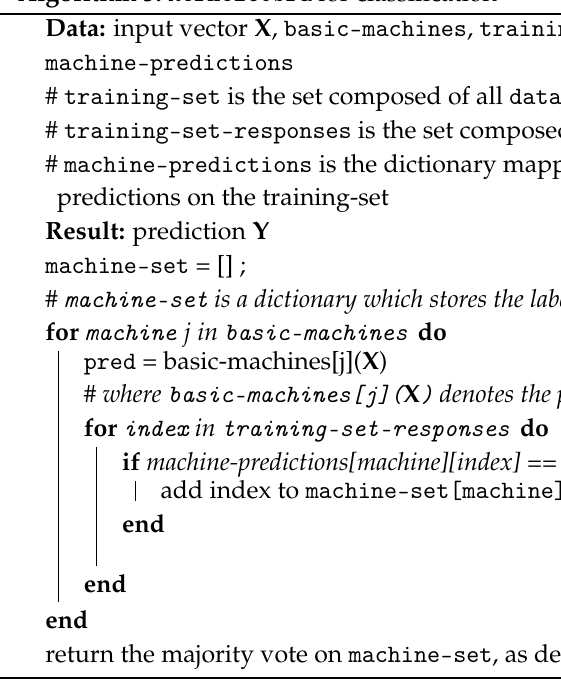
Algorithm 3: KernelCobra for